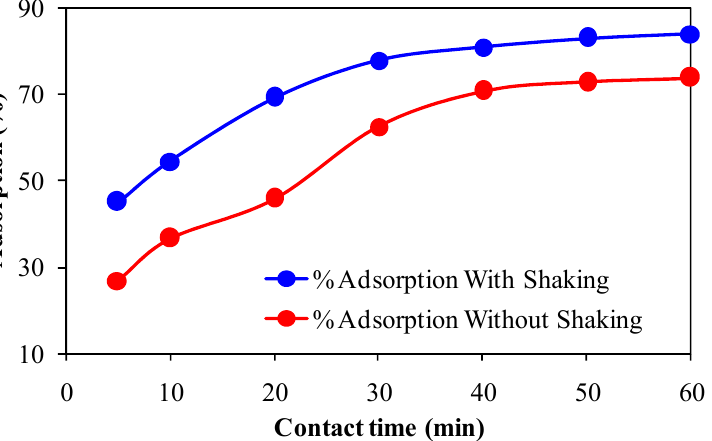
Figure 4. Effect of contact time on the biosorption of RBV-5R using SCB at 20 µg/mL RBV-5R, pH 6, 0.15 g SCB.